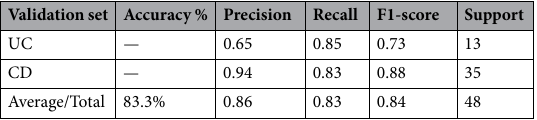
Table 3. Performance of the trained combined model over the validation